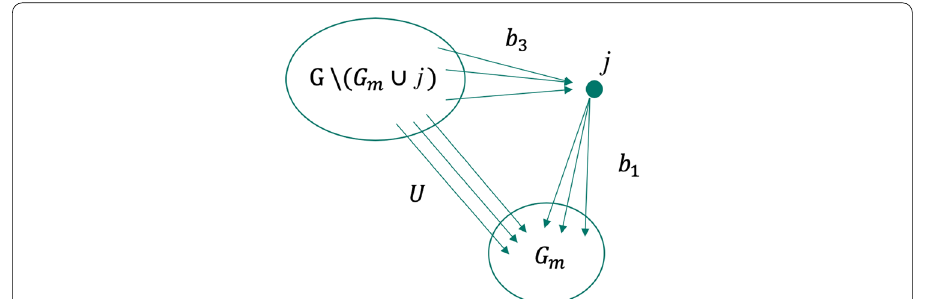
Fig. 1 TCEC sampling visual representation. Consider a candidate node j to be added to the current sample G m . The algorithm considers: the outgoing connections b 1 towards the sample, the incoming connections b 3 from the non-sampled nodes and U , the remaining edges incoming towards the